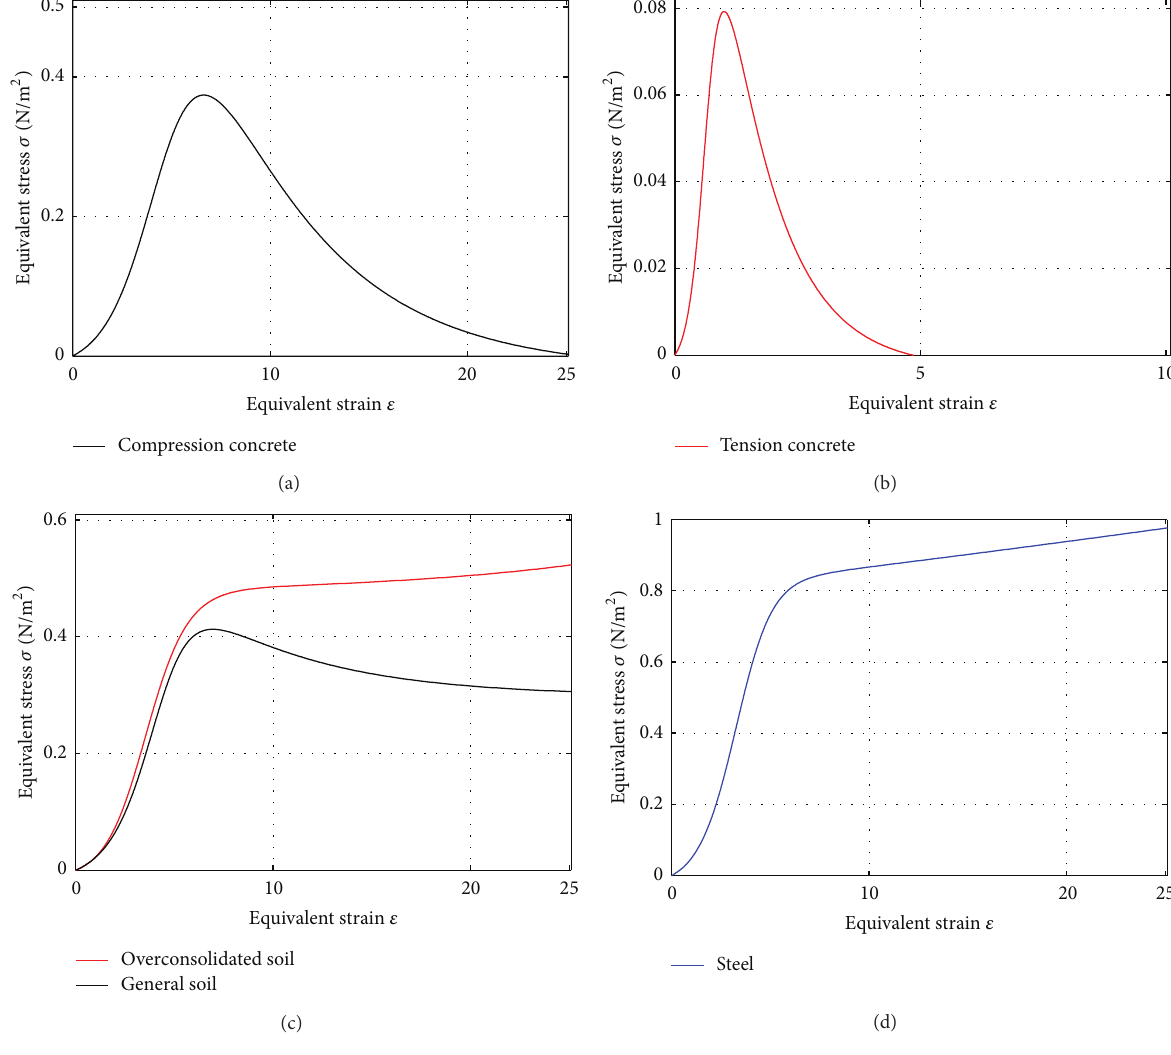
Figure 3: Constitutive curves for different engineering material based on SIR